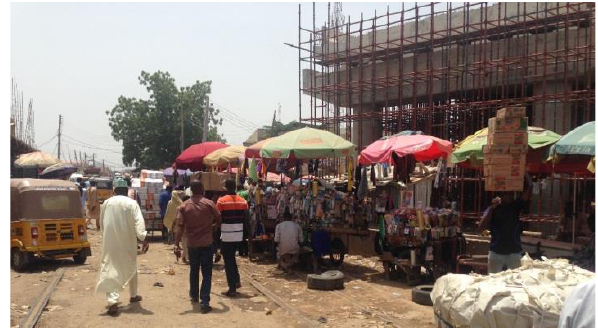
Figure 6 : Mobile vendors on derelict lands that allows for temporal but steady informal activity. Vendors can invest in karts with umbrellas. Due to the constant ability to trade, vendors have a slightly higher amount of merchandise to trade and can continue to make improvements to their vending devices. Source: Authors (2017).